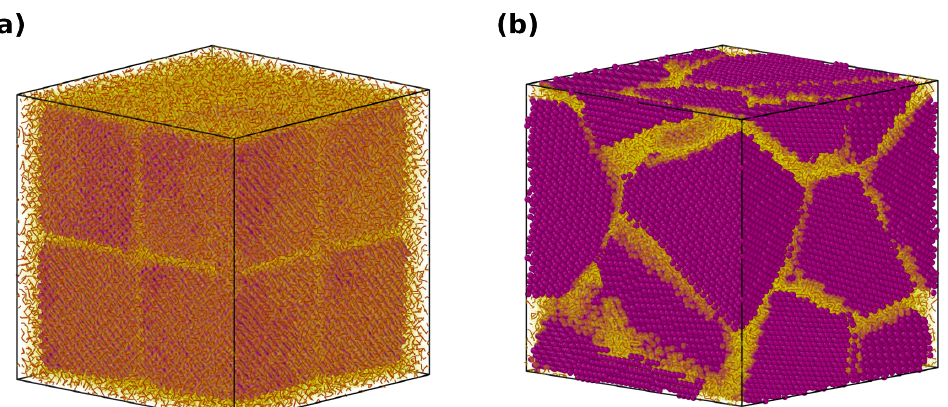
Figure 2. Equilibrated system snapshot of ( a ) columnar, ( b ) staggered nacre-like composites. Magenta and yellow represent the beads of crystalline domain and beads of polymer chains,